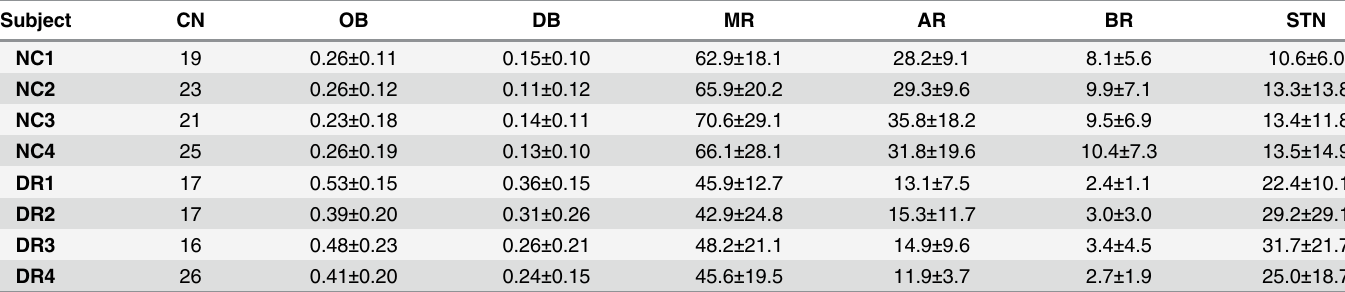
Table 1. Measures of the cell number (CN), mean orientation bias (OB), motion direction bias (DB), maximum response (MR) to the preferred stimu- lus orientation, average response (AR) to all stimulus orientations, baseline response (BR) and signal-to-noise ratio (STN) for studied neurons of